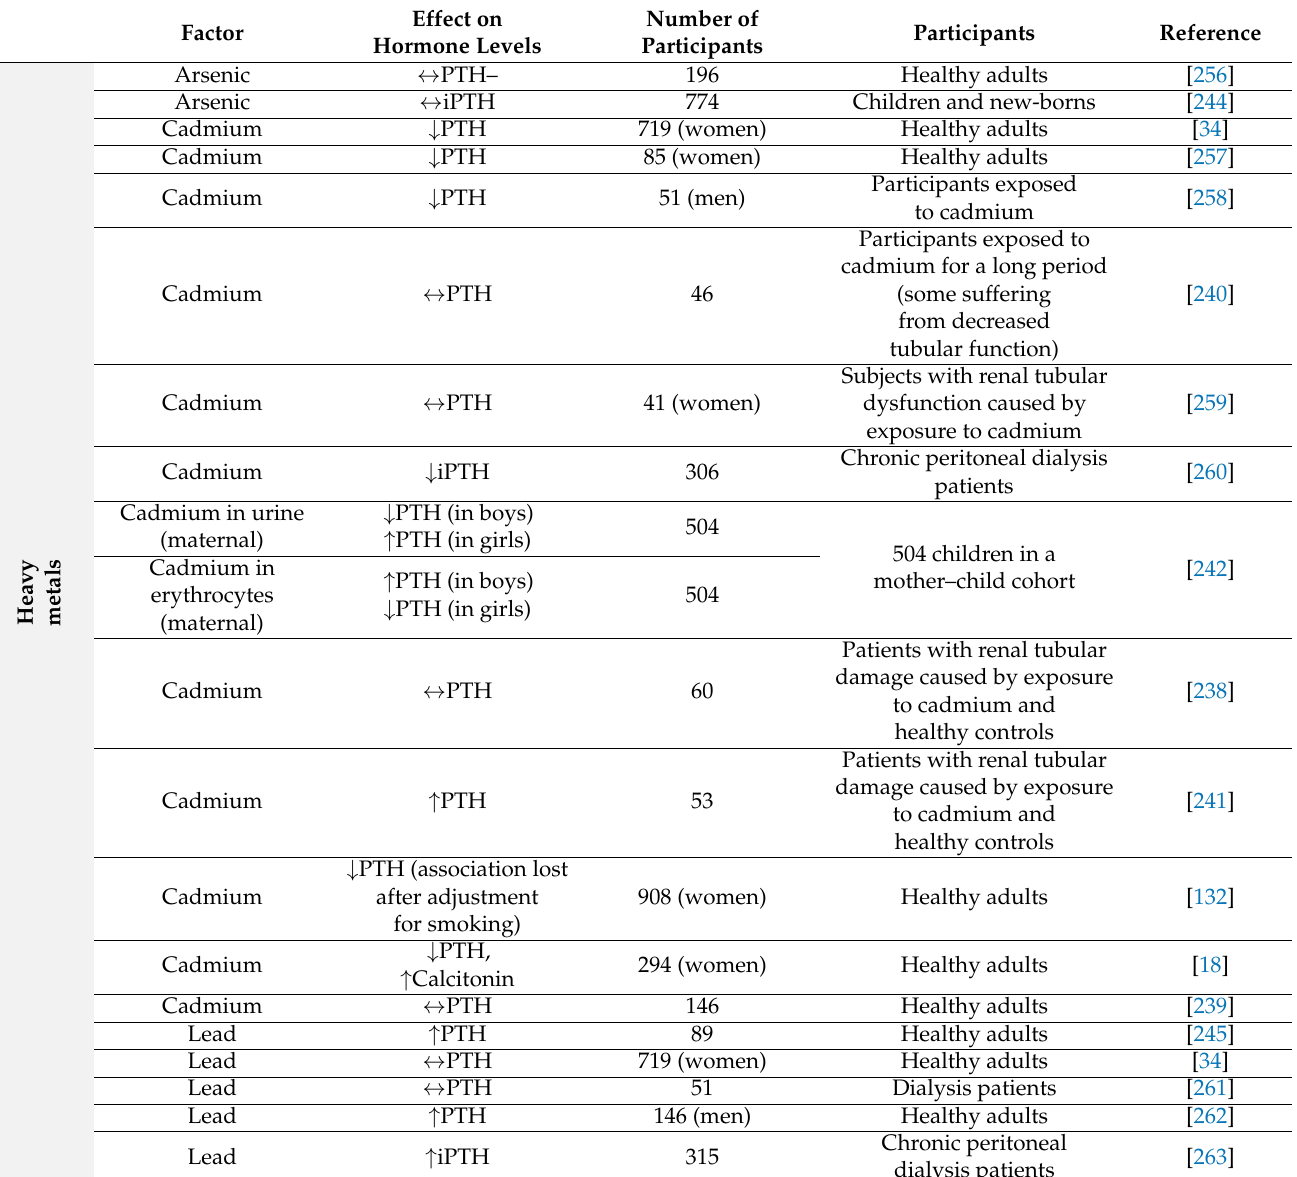
Table 3. Pollutants affecting PTH and calcitonin levels in